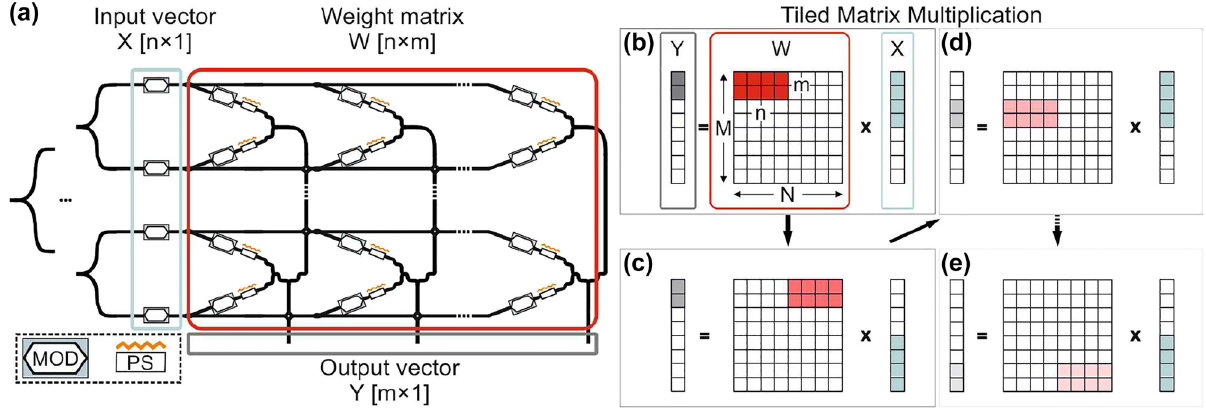
Figure 1: Linear operator architecture and TMM: (a) n × m crossbar architecture for vector (1 × n ) matrix ( n × m ) multiplication. (b)–(e) Tiled vector (1 × N ) matrix ( N × M ) multiplication via a 1 × n vector and n × m matrix encoding